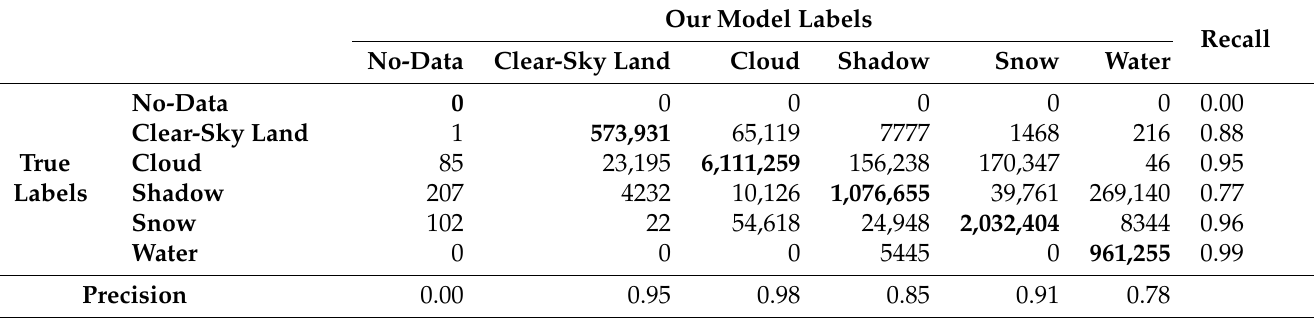
Table 7. Confusion matrix comparing the predictions of our model with the true labels in the test